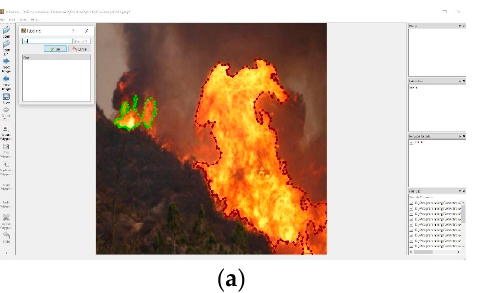
Figure 3. Image annotation; ( a ) fire, ( b ) non-fire.